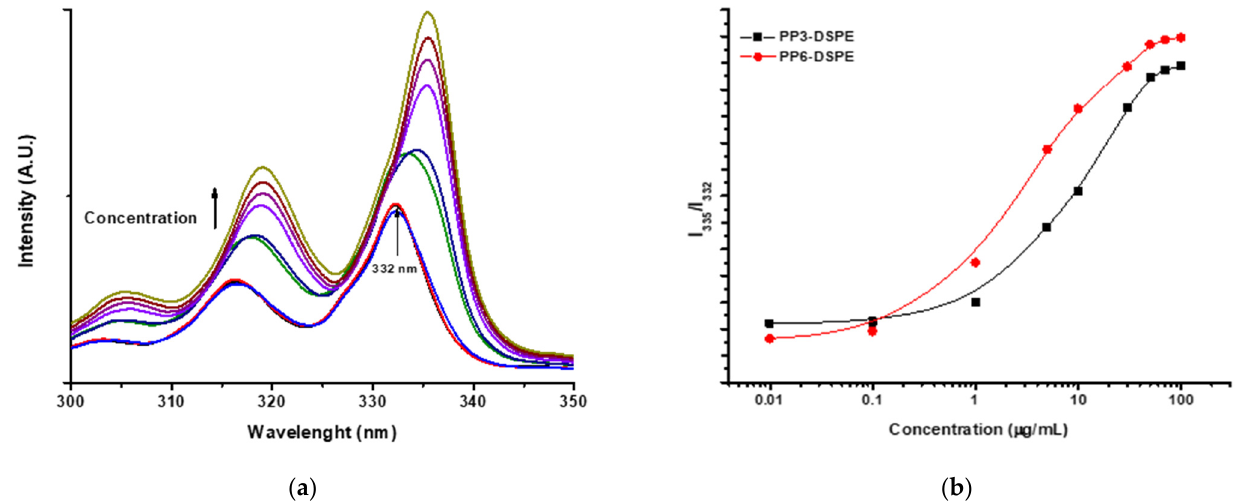
Figure 2. Excitation spectra of pyrene dissolved in PP3-DSPE solutions with different concentrations ( a ) and plot of the ratio of the fluorescence intensity of pyrene at 335 and 332 nm as a function of copolymer concentrations for PP3-DSPE and PP6-DSPE samples ( b ).